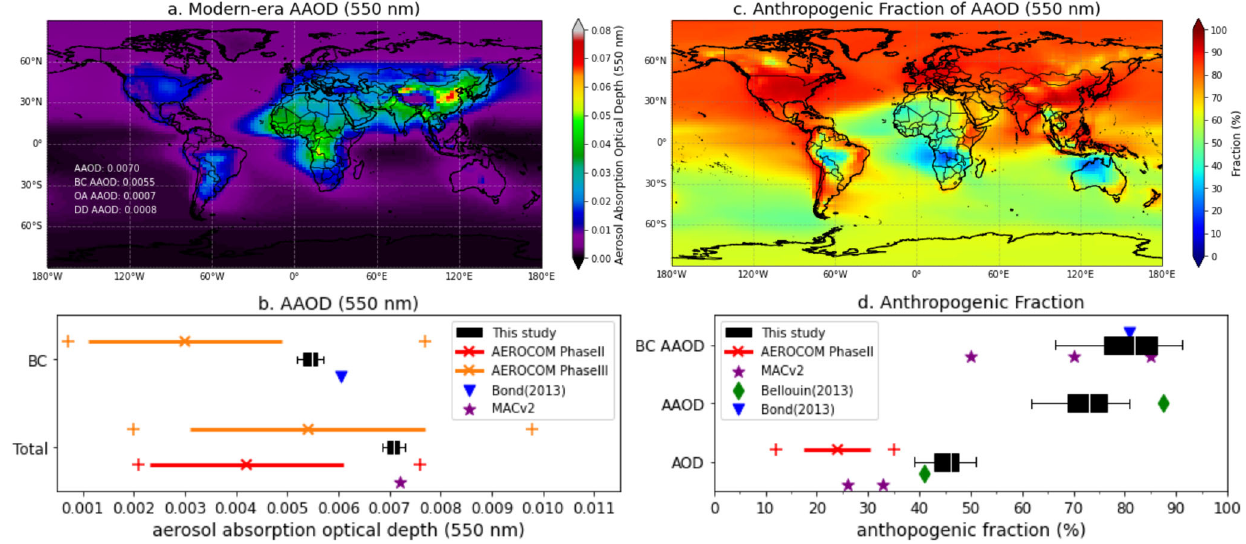
d Estimation of global mean anthropogenic fraction of AOD, AAOD, and black carbon (BC) AAOD and intercomparison with AeroCom Phase II, Bond 9 , MACv2 51